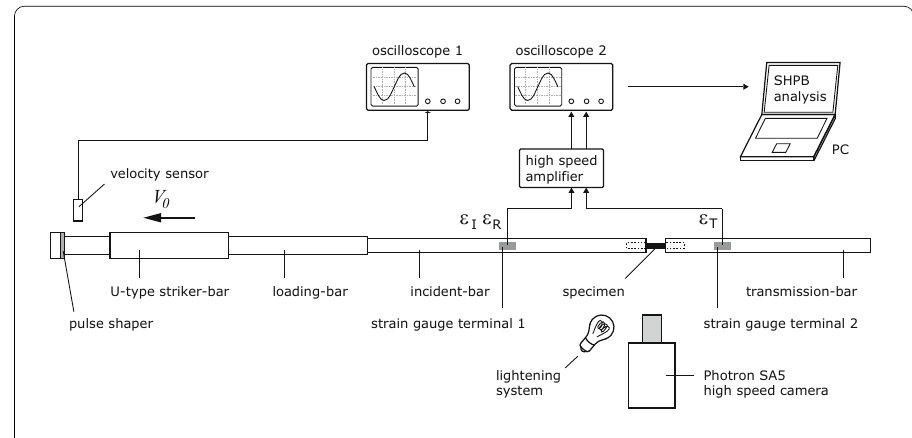
Fig. 3 Split-Hopkinson tension bar setup for dynamic tests (striker-bar acceleration system not shown)